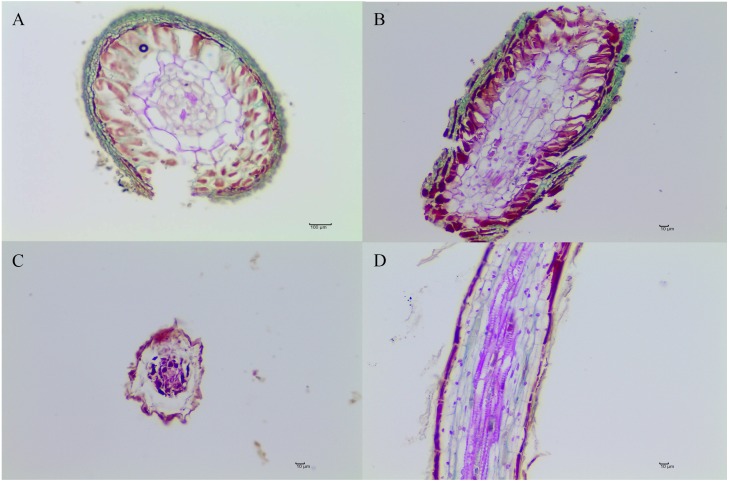
The morphological characteristics of T. indicum ectomycorrhizae (A, B) and control roots tips that were not colonized by T. indicum (C, D).A and C, transversal sections; B and D, longitudinal sections.